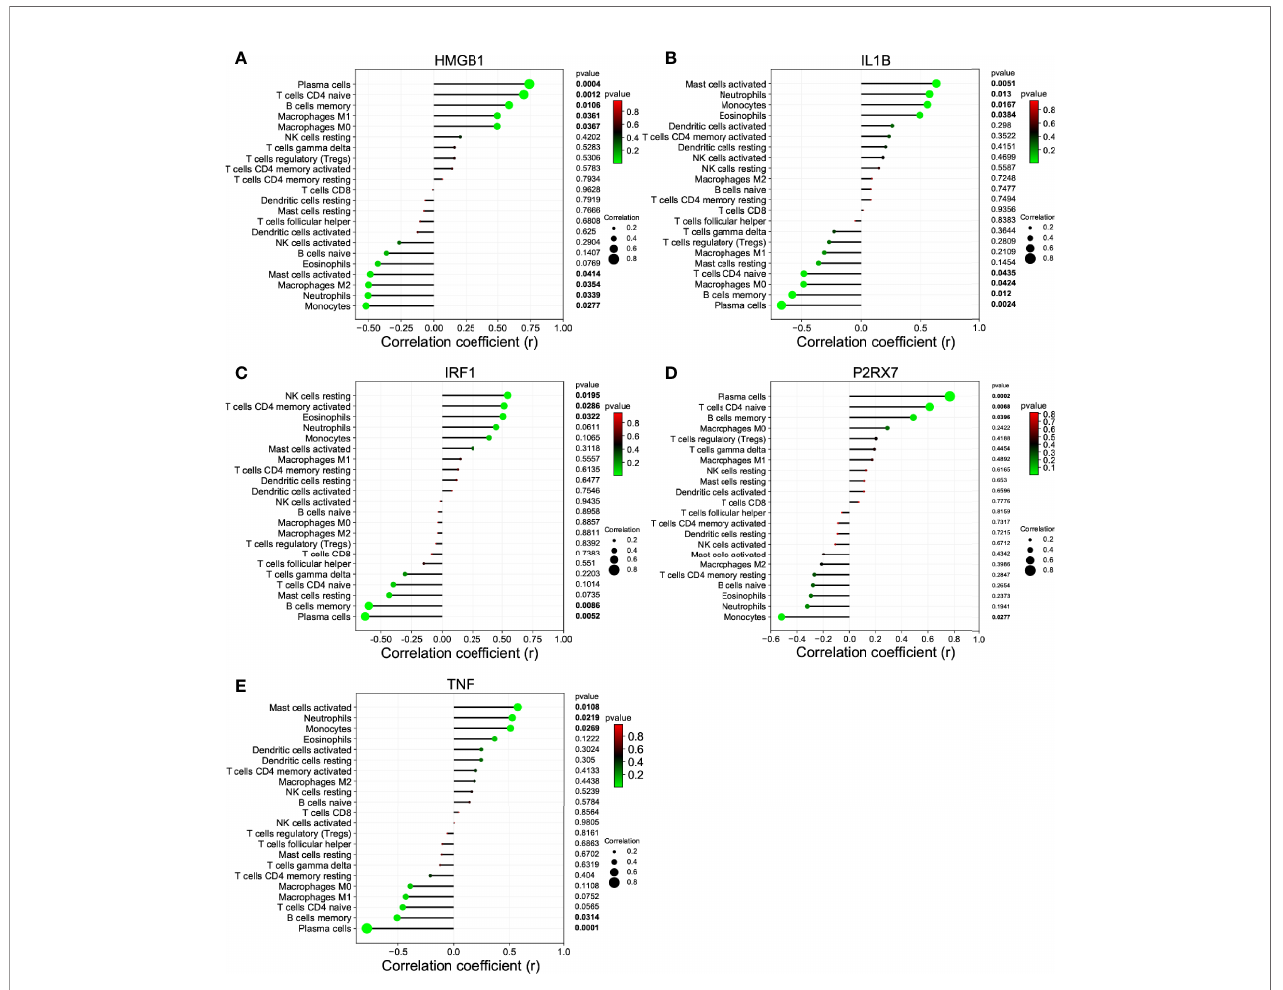
FIGURE 6 | The correlation between the hub gene and the immune cell. (A) HMGB1; (B) IL1B; (C) IRF1; (D) P2RX7; and (E)